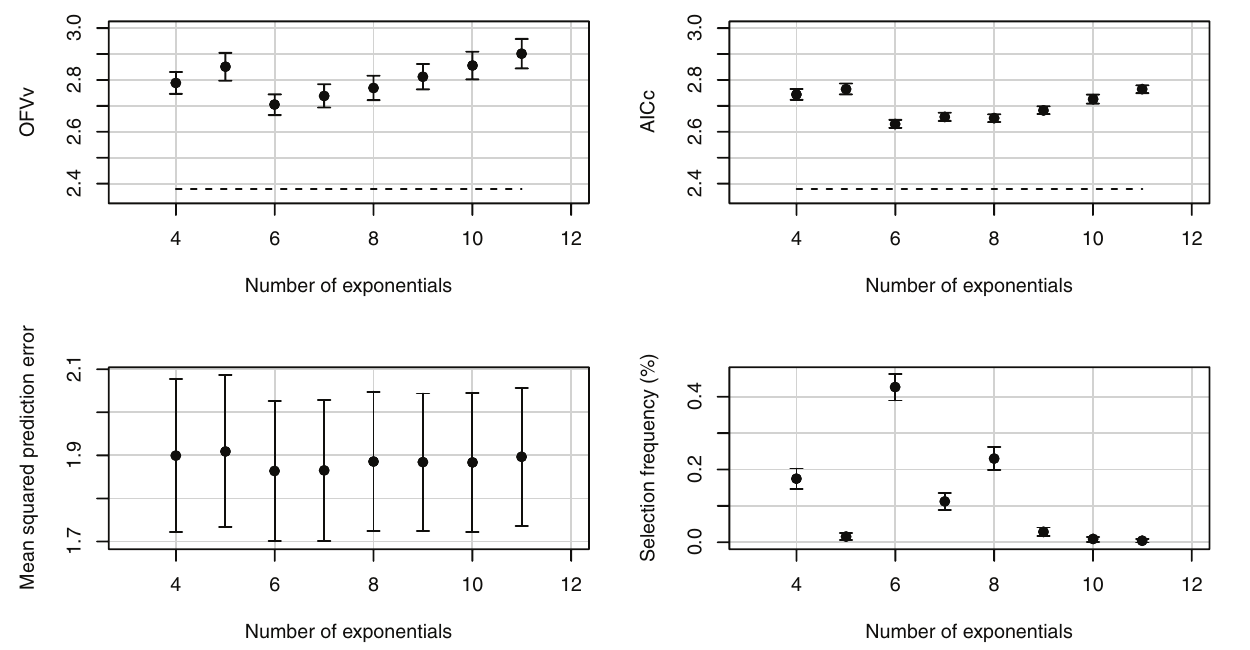
Figure 5. Mean OFV , AIC , prediction error ν 2 , and model selection frequencies as a function of the number of exponentials, for ω 2 = 0.5; v c parameters otherwise identical to those for Figure 3.